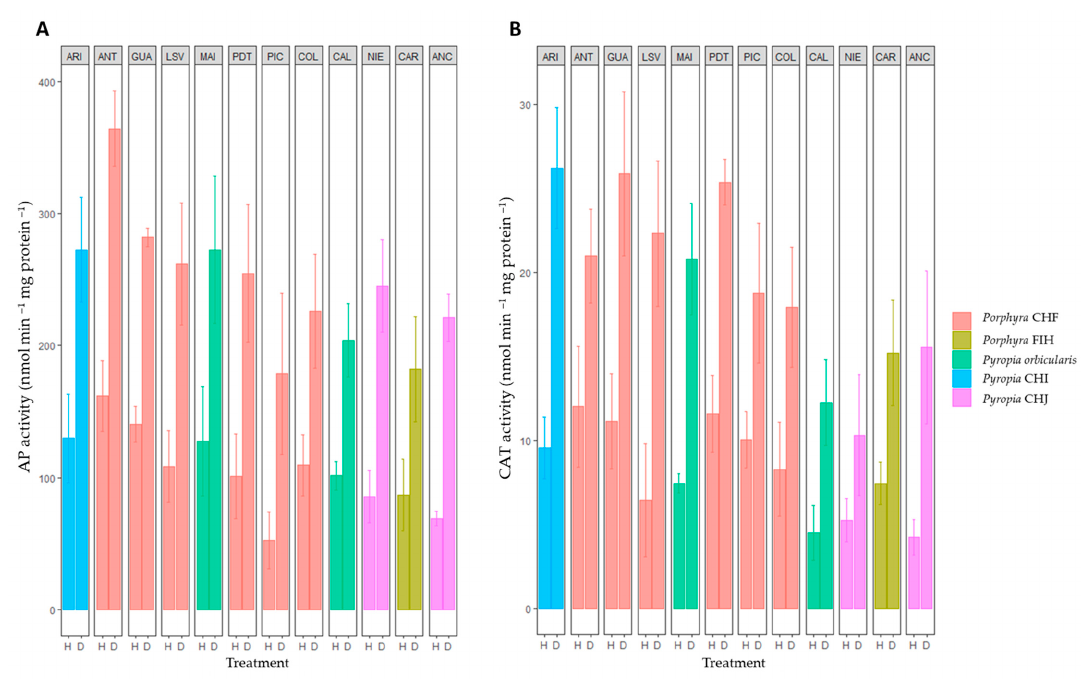
Figure 2. Specific activity of ( A ) AP (ascorbate peroxidase) and ( B ) CAT (catalase) during in situ hydration (H) and desiccation (D) stress in the Porphyra and Pyropia species evaluated in this study. Values are the mean ± SD of three replicates. ARI, Arica; ANT, Antofagasta; GUA, Guanaquerillos; LSV, Los Vilos; MAI, Maitencillo; PDT, Punta de Tralca; PIC, Pichilemu; COL, Coliumo; CAL, Calfuco; NIE, Niebla; CAR, Carelmapu; and ANC, Ancud (see Table 1 and Figure 6 for in-depth information). Globally, the differences in activity can be explained mainly by the highest activity values recorded in Porphyra CHF for AP from Antofagasta (Figure 2A) and for CAT in Pyropia CHI from Arica and Porphyra CHF from Guanaquerillos (Figure 2B). Nonetheless, for AP and CAT, a gradual increase in the enzyme activities was generally observed within species from south to north (except within Pyropia CHJ for CAT). If we focus our attention on each species separately and on their mean PRX and TRX activities (Figure 3A,B), there was no distinct pattern of a latitudinal trend of higher or lower mean values (except within Pyropia orbicularis for PRX) but rather a plastic within species, locally de- pendent on the physiological performance.